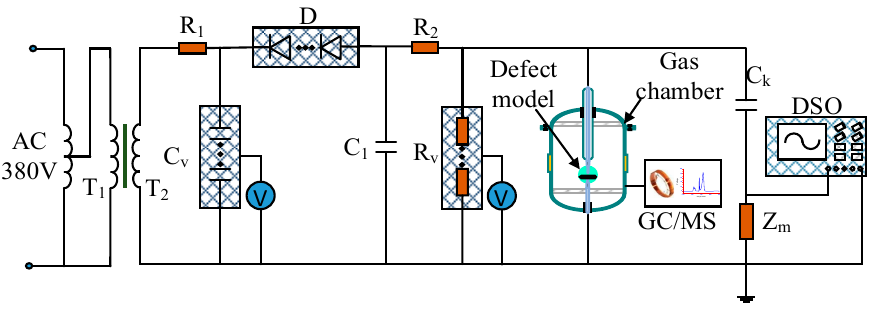
Figure 1. SF 6 decomposition test wiring diagram under DC PD.